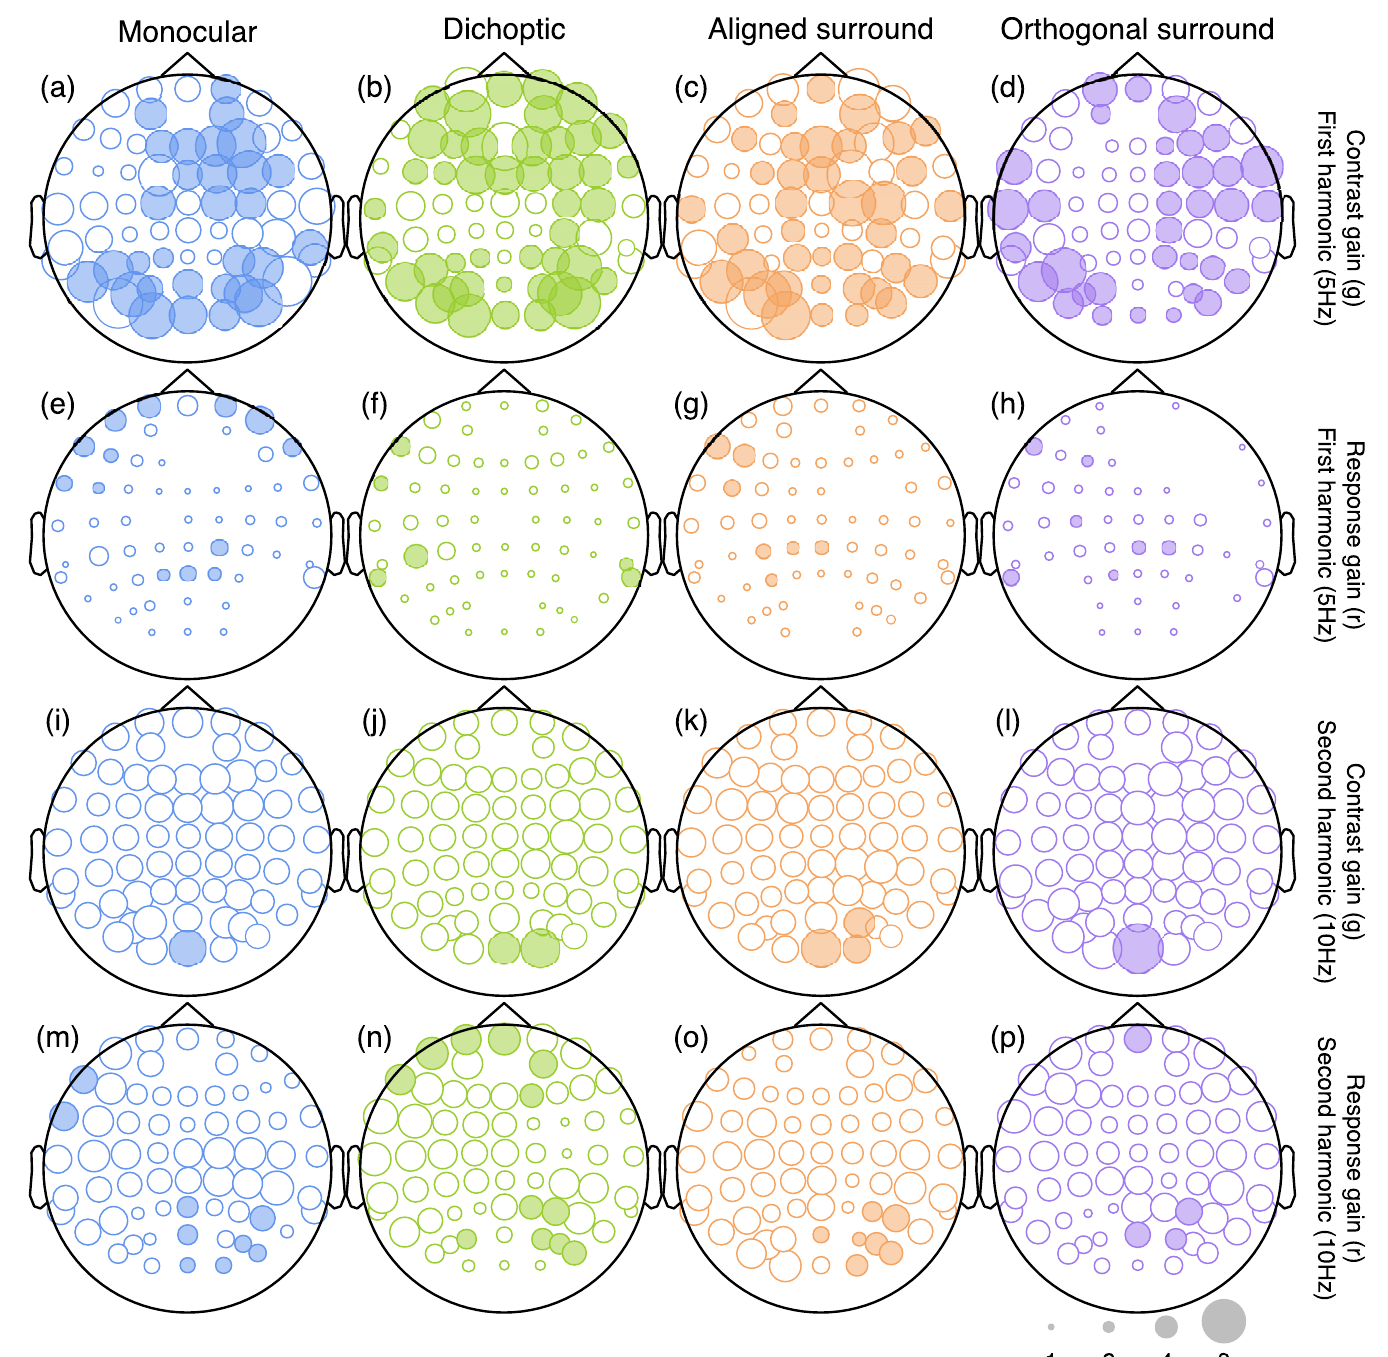
Fig 5. Scalp plots summarising the suppressive weights for contrast and response gain from the Bayesian hierarchical model, fitted to data from the low mask contrast experiment. Symbols are filled white when the 95 percent highest density interval of the posterior parameter distribution includes 1 (implying no credible contribution from that type of suppression), and shaded when it exceeds 1 (implying credible evidence for suppression). Larger symbols correspond to stronger suppression (see the scale in lower right corner), but parameters implying facilitation (values < 1) are not plotted.